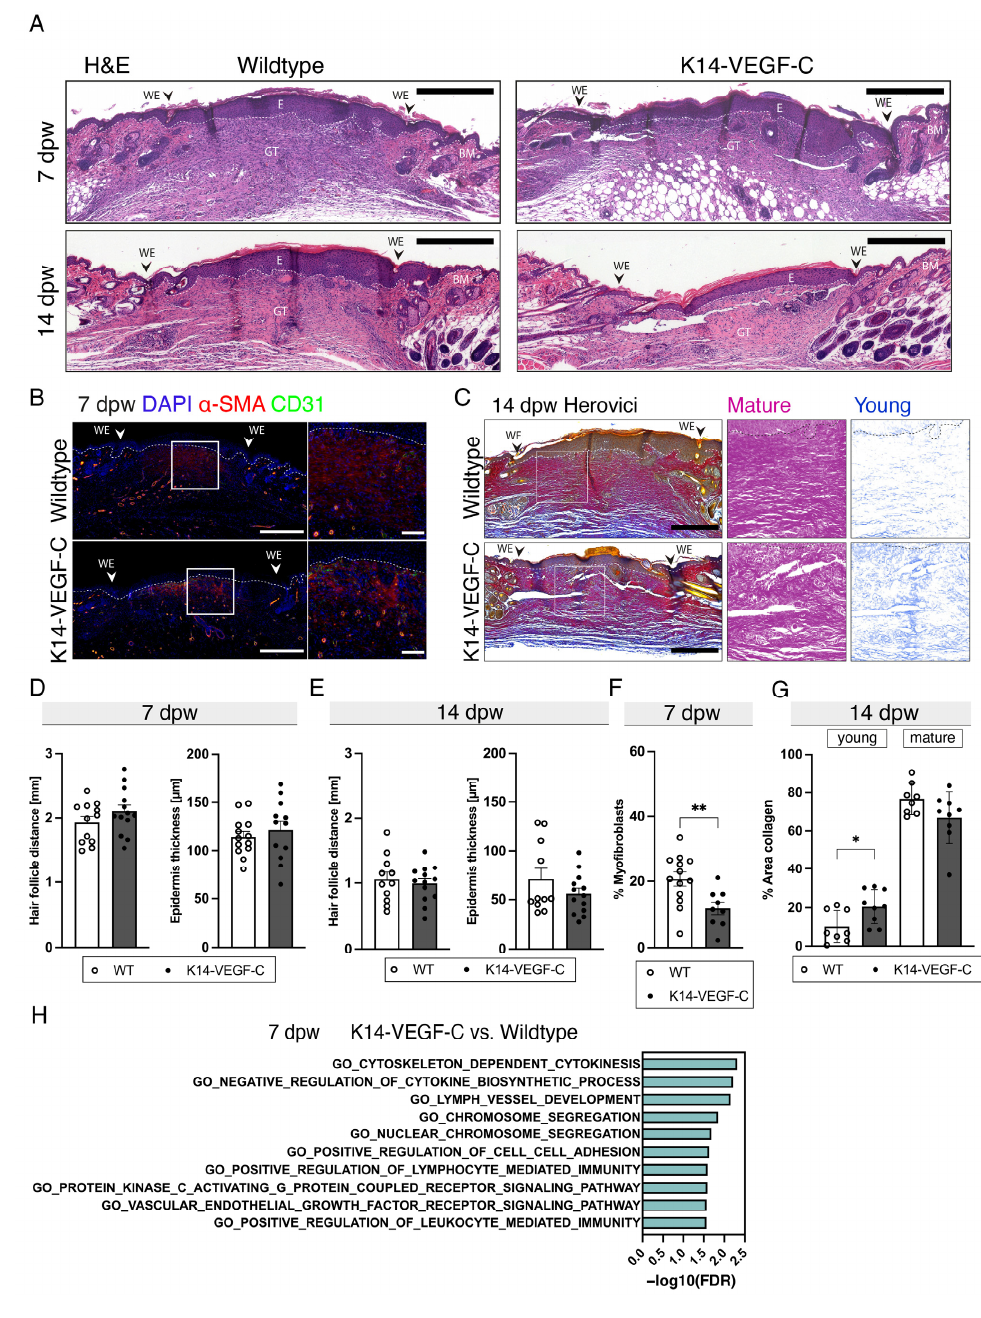
Figure 4. Increased lymphatic vessel area reduces myofibroblast density and delays collagen maturation. ( A ) H&E representative sections of WT and K14-VEGFR3-Fc transgenic mice at 3- and 10 dpw. Scale bar: 500 µ m. ( B ) Representative α -SMA and CD31 stained sections of WT and K14-VEGF-C mice 7 dpw. Scale bars: Overview: 500 µ m, Zoom-in: 100 µ m. ( C ) Herovici’s stain representative sections of WT and K14-VEGF-C mice 14 dpw. Single-channel images of Herovici staining for the colors of mature (purple) and young (light blue) collagen are shown. Scale bars: Overview: 500 µ m, mature, young: 100 µ m. ( D ) Hair follicle distance [mm] and epidermis thickness [ µ m] of WT and K14-VEGF-C mice at 7 dpw. N = 12–13 wounds of 5 mice. Scale bars: 500 µ m. ( E ) Hair follicle distance [mm] and epidermis thickness [ µ m] of WT and K14-VEGF-C mice at 14 dpw. N = 11–13 wounds of 5